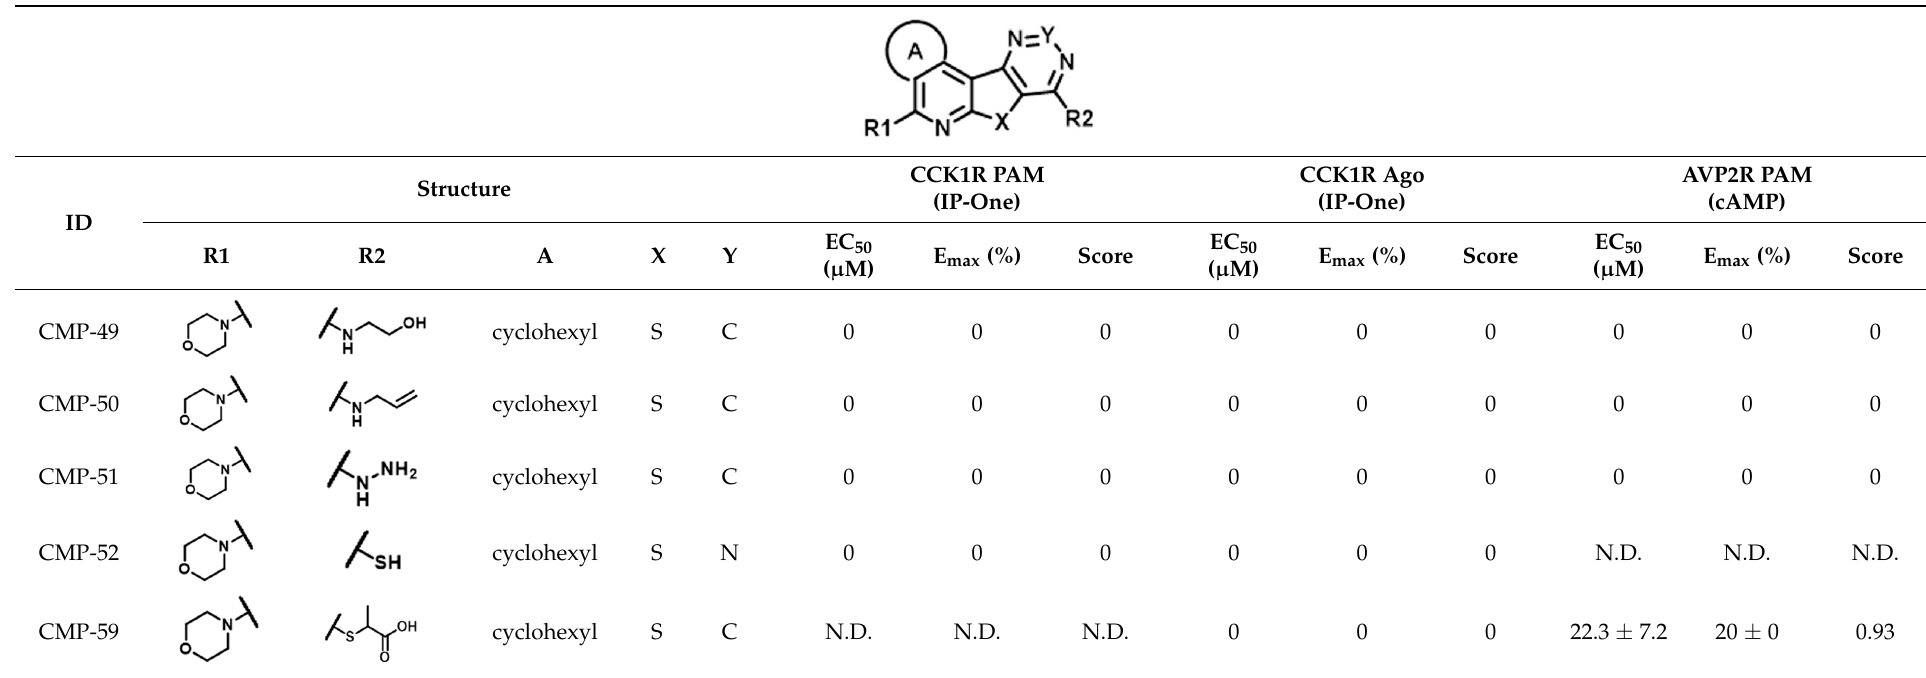
Table 4. Cont. Table 4. Structure–activity studies of 15 morpholine analogs with non-basic amine R2 substitutions.